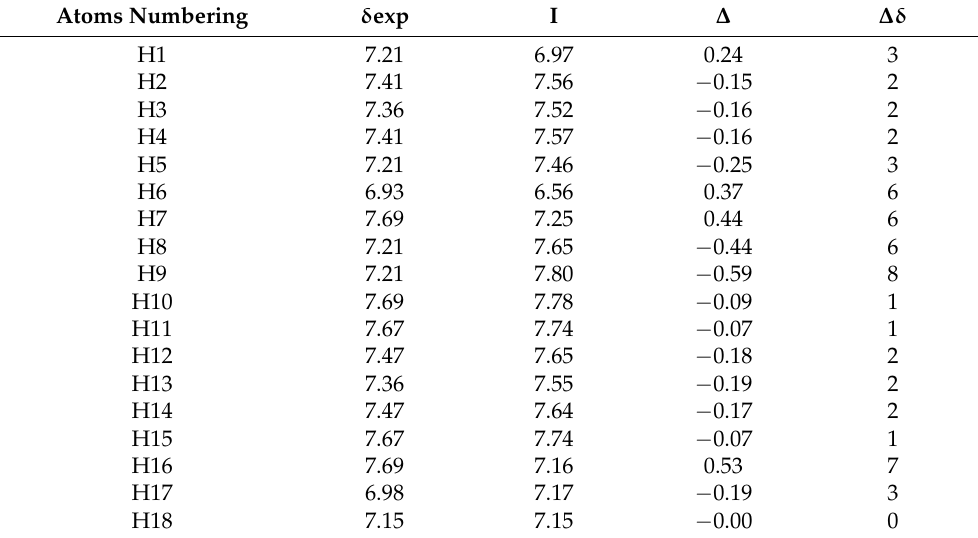
Table 10. Experimental ( δ exp ) and calculated chemical shifts ( I ) for compound 2 ; errors ( ∆ ), relative percentage errors ( ∆ δ ); calculated NMR shielding (B3LYP/631G(d,p)//B3LYP/6-31G(d,p)/DMSO) for proton H ref = 31.7468 ppm for TMS; MAD = 0.24 (atoms numbering as is in Figure 1). Atoms Numbering δ exp I ∆ ∆ δ